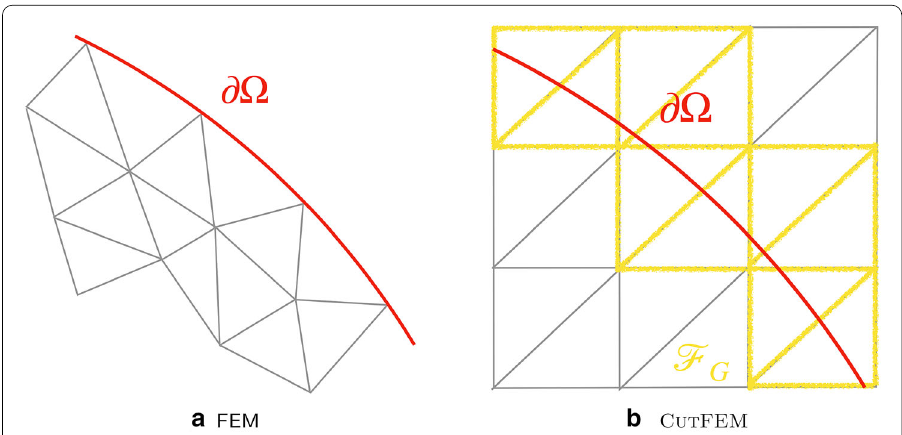
Fig. 2 a Standard FEM requires the mesh to be conform the boundary of the domain ∂(cid:3) b CutFEM embeds the implicitly defined interface ∂(cid:3) into a background mesh, in yellow the set of ghost penalty facets F